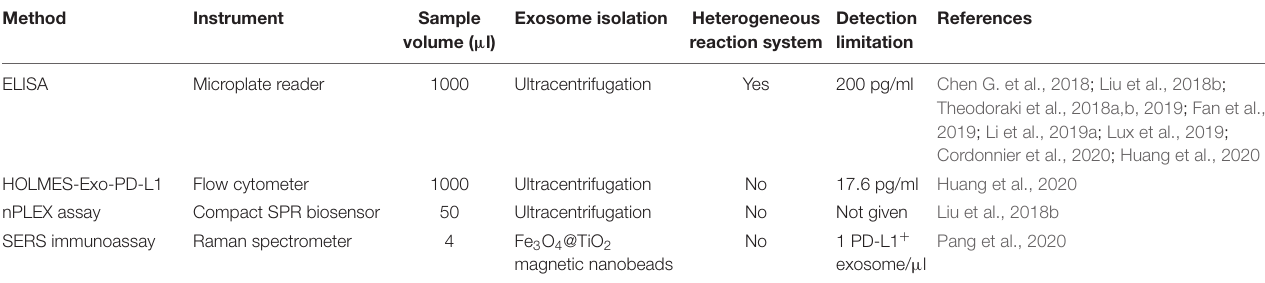
TABLE 3 | Comparison of methods for detecting ExoPD-L1 in clinical samples.